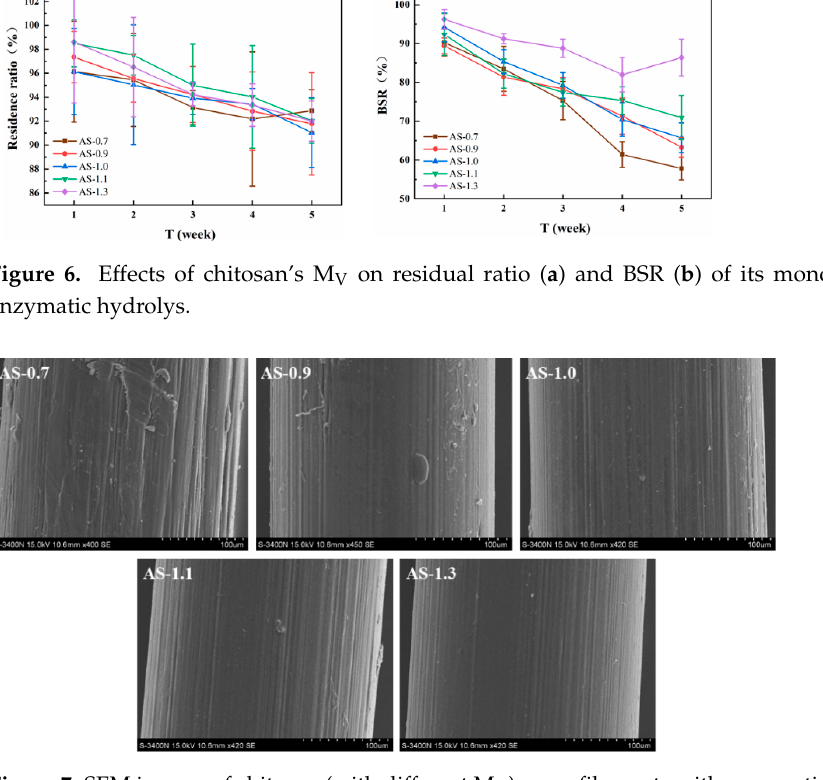
Figure 7. SEM images of chitosan (with different M V ) monofilaments with enzymatic hydrolysis for five weeks.